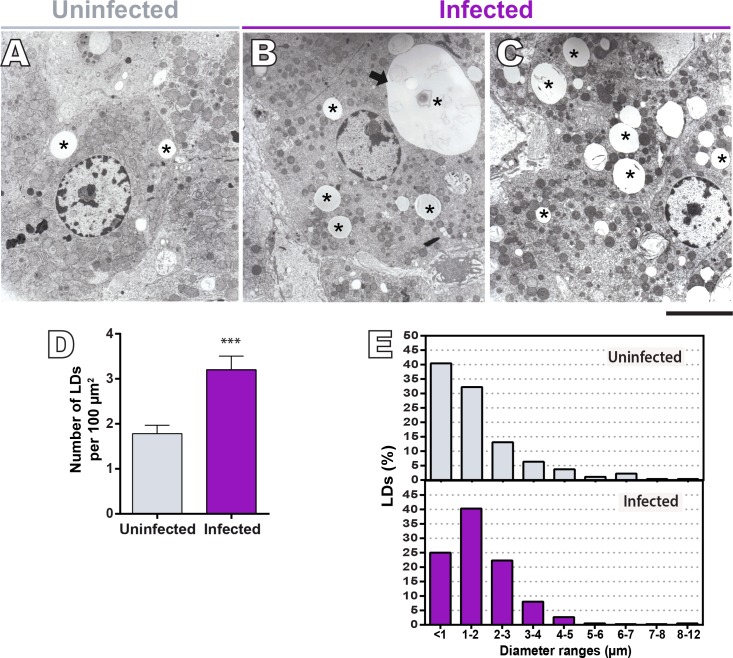
Ultrastructure of LDs formed in the liver of uninfected and naturally S. mansoni-infected N. squamipes.(A-C) Electron micrographs of the hepatic tissue reveal electron lucent LDs with varied sizes within hepatocytes in both control (A) and infected (B, C) livers. Note in (B), a giant LD (arrow) in the hepatocyte cytoplasm. (D) TEM quantitative analyses show a high number of LDs per tissue area (P < 0.002). The range of LD diameter is shown in (E). Scale bar, 9 μm (A-C). Liver fragments were fixed in a mixture of paraformaldehyde/glutaraldehyde and processed for TEM. Quantitative analyses were performed in a total of 34,000 μm2 of hepatic tissue (17,000 μm2 from uninfected and 17,000 μm2 from infected animals) using the software ImageJ. Data represent mean ± S.E.M. ***P < 0.0001 for infected versus uninfected group.